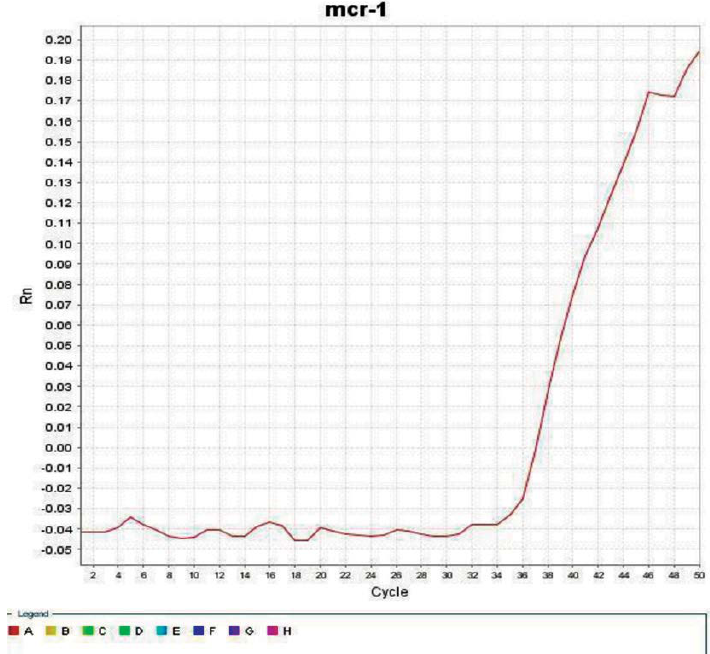
Fig. 4. Real time PCR show mcr-1 gene expression, presented ct at 36